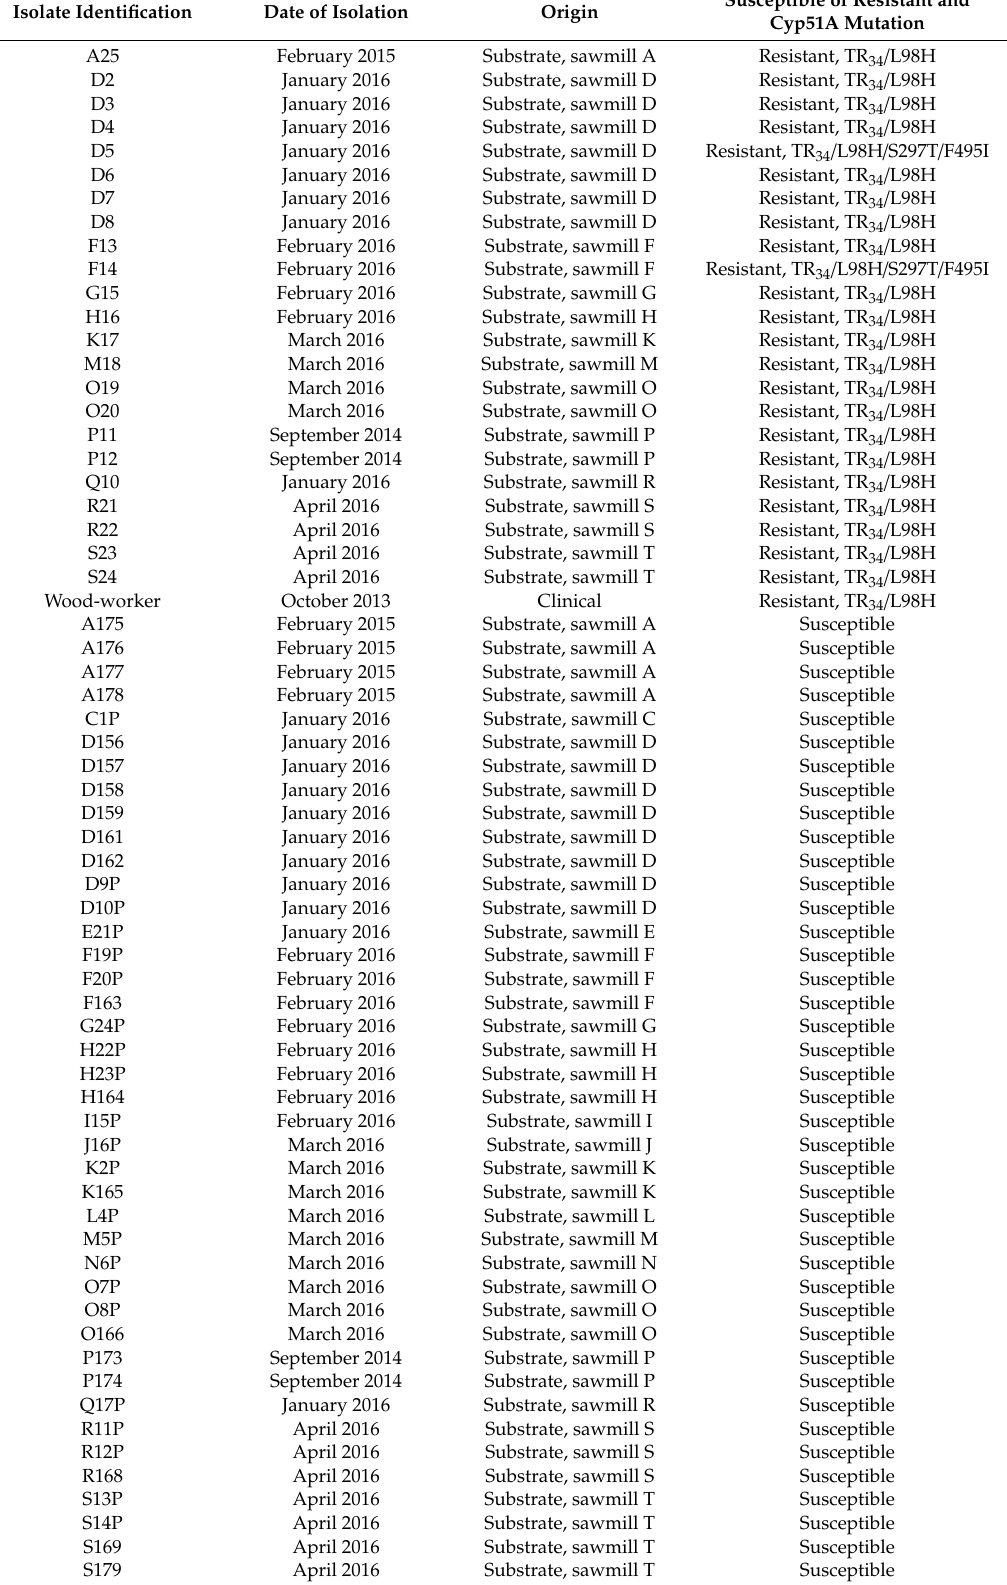
Table 1. Characteristics of analyzed azole-resistant (AR Af ) and azole-susceptible (AS Af ) A. fumigatus . Isolate